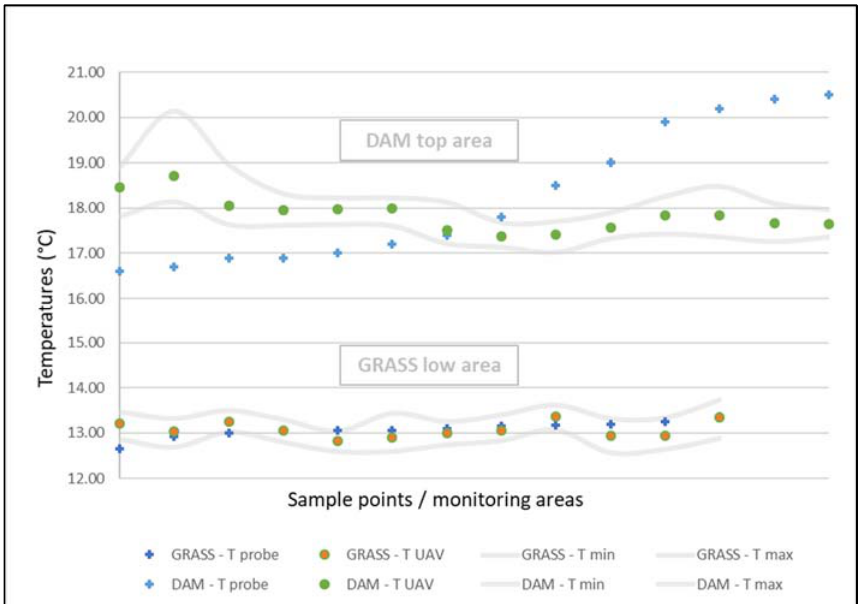
Figure 4. Comparison of measured/monitored